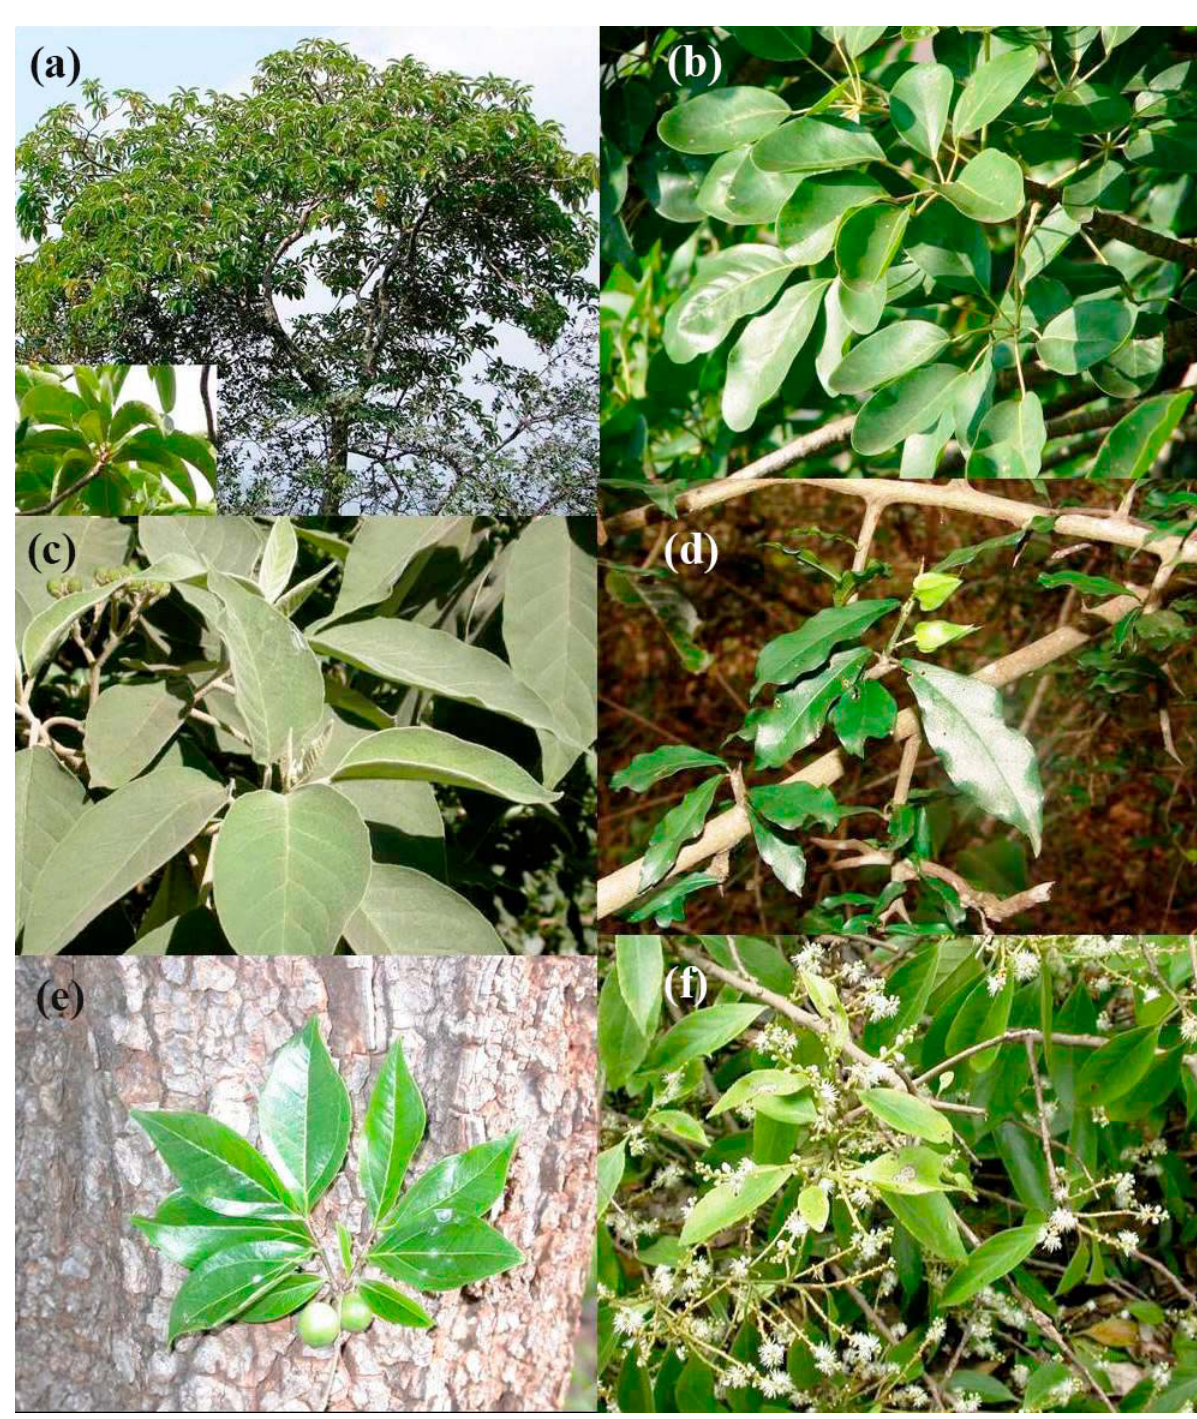
Figure 17. a) Sapium insigne (Euphorbiaceae); b) Schefflera stellata (Araliaceae); c) Solanum erianthum (Solanaceae); d) Streblus taxoides (Moraceae); e) Strychnos potatorum (Loganiaceae); f) Symplocos cochinchinensis (Symplocaceae). Photo by L. Arul